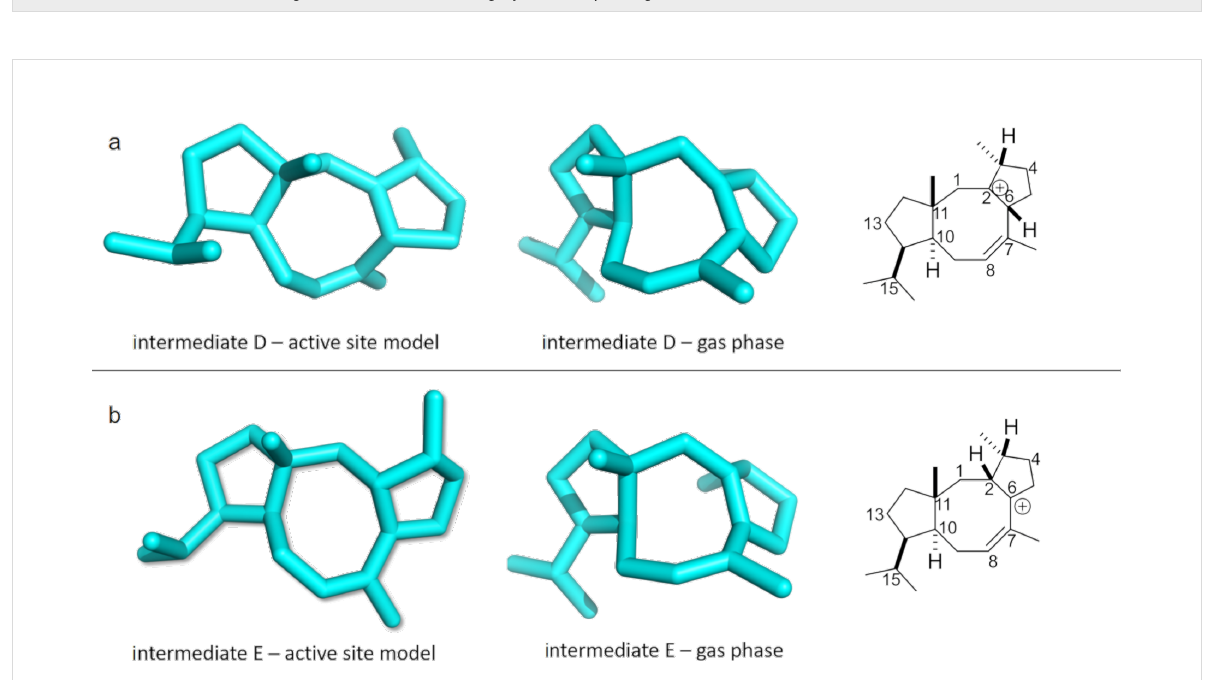
Figure 4: Comparison between gas phase and active site model conformations. A) Intermediate D . B) Intermediate E .